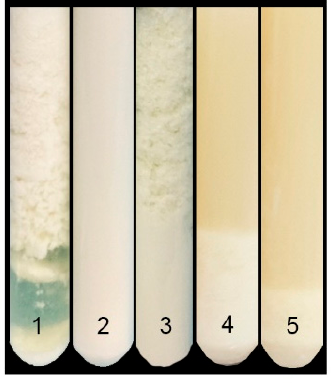
Figure 1. Test tubes of curd formation using M. oleifera crude extracts on whole milk. 1: Calf rennet (positive control); 2: NaCl 5% (negative control); 3: Seed extract; 4: Flower extract; 5: Leaf extract. Table 1. Values of whole milk-clotting activity from the different parts of M. oleifera . Crude Extract Protein Concentration (mg/mL) Total MCA (SU/mL) Specific Activity (SU/mg Protein) Seeds 10.30 ± 0.45 3419.26 ± 186.80 331.96 Flowers 10.62 ± 0.77 13.66 ± 1.12 ** Leaves 28.43 ± 3.04 * ND ND Calf rennet 14.10 ± 0.95 6060.6 ± 0.71 *